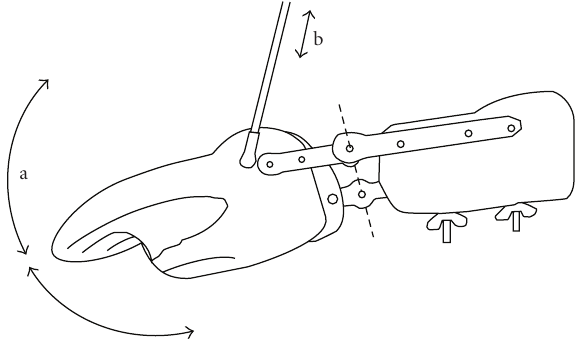
Figure 1: Scheme of the splint (top view) with a joint at the wrist. The right hand was positioned with the thumb upwards. The hand movement angle (a) is mechanically transmitted by the connecting rod (b) to a digital goniometric sensor over a distance of about 100 cm to reduce ferromagnetic